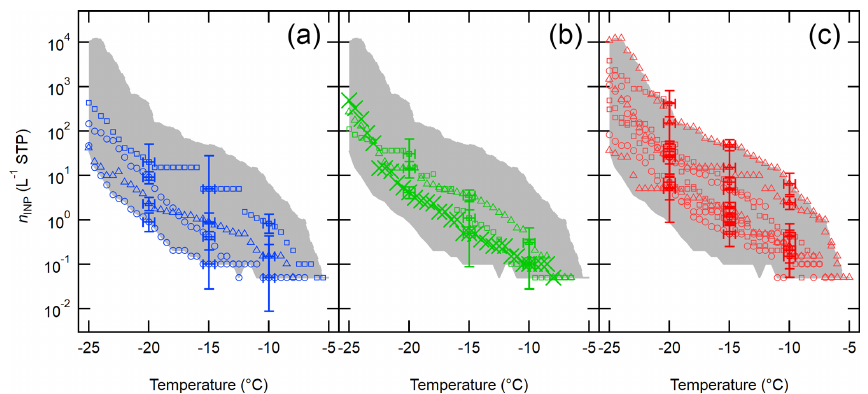
Figure 6. Downwind OLLF n INP spectra from 2017 to 2019 sorted based on meteorological seasons are shown: winter (a) , spring (b) , and summer (c) . The uncertainties in temperature and n s , geo are ± 0 . 5 ◦ C and ± CI95%, respectively, and error bars are shown at − 5, − 10, and − 15 ◦ C. The shaded area represents minimum − maximum n INP .